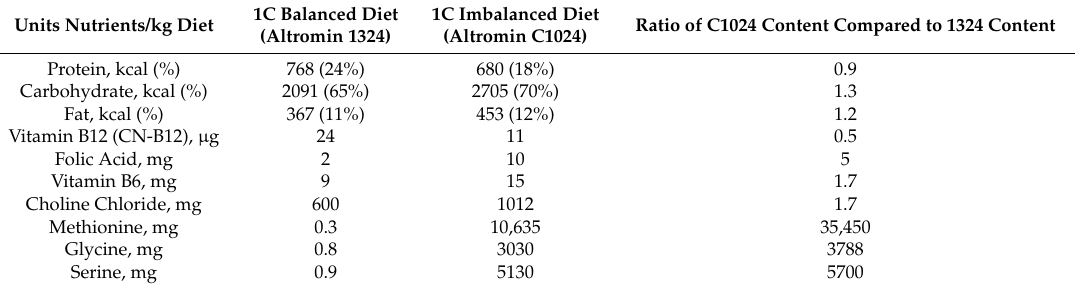
Figure 1. Study design. Abbreviations: CN*: [ 7 Co]CN-B12, HO*: [ 57 Co]HO-B12. 1C: one-carbon. Table 1. Dietary composition of the 1C balanced diet and the 1C imbalanced diet. Compared with the 1C balanced diet (standard rat diet) (Altromin 1324 from Brogaarden, https://altromin.com/pdf/en/ 1320), the 1C imbalanced diet (Altromin C1024 fra Brogaarden, https://altromin.com/pdf/en/C1024) contained half the amount of B12 and was higher in content of folate, B6, choline chloride, methionine, glycine, and